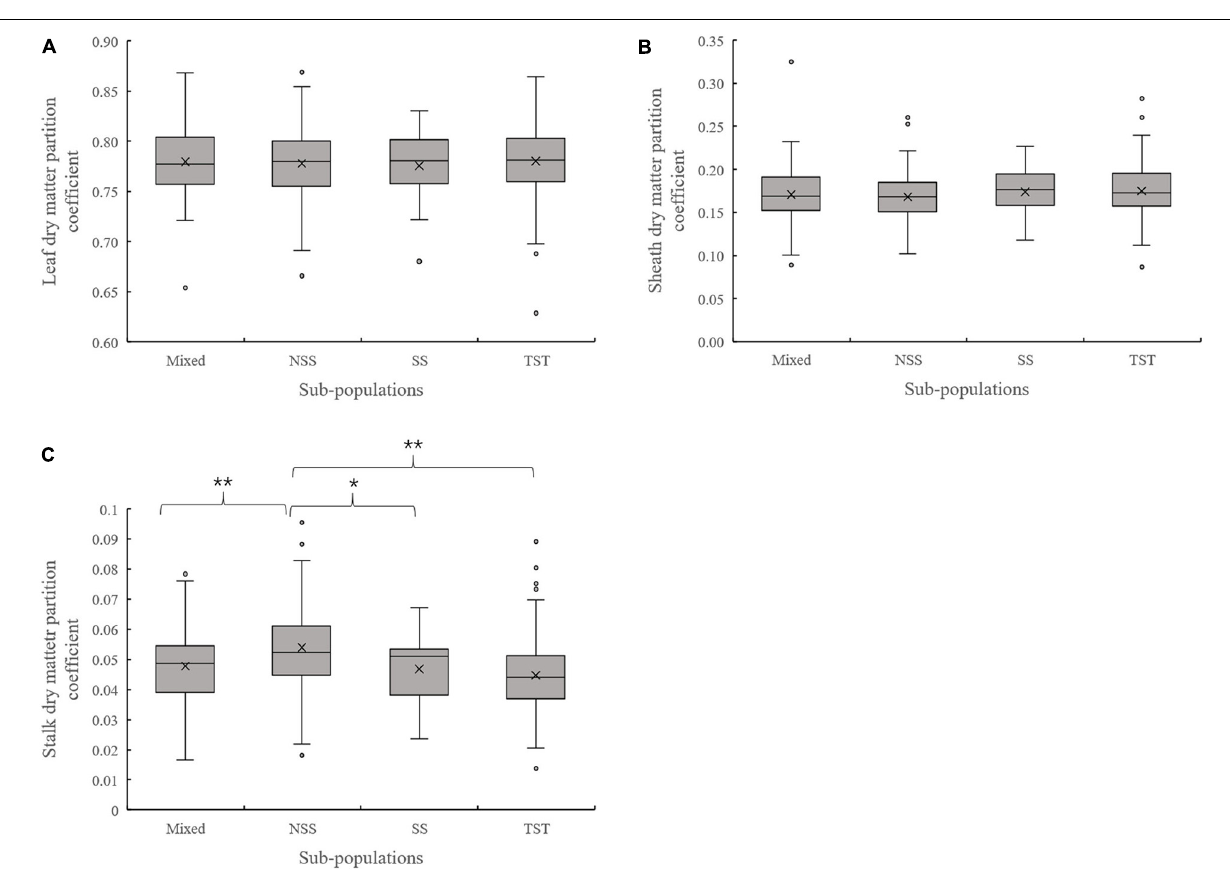
FIGURE 4 | Boxplot of the different organ’s dry matter partition coefficients in different subpopulations at the V6 stage. ** denotes significant differences between subpopulations at P ≤ 0.01. * denotes significant differences between subpopulations at P ≤ 0.05. (A) Leaf dry matter partition coefficient. (B) Sheath dry matter partition coefficient. (C) Stalk dry matter partition